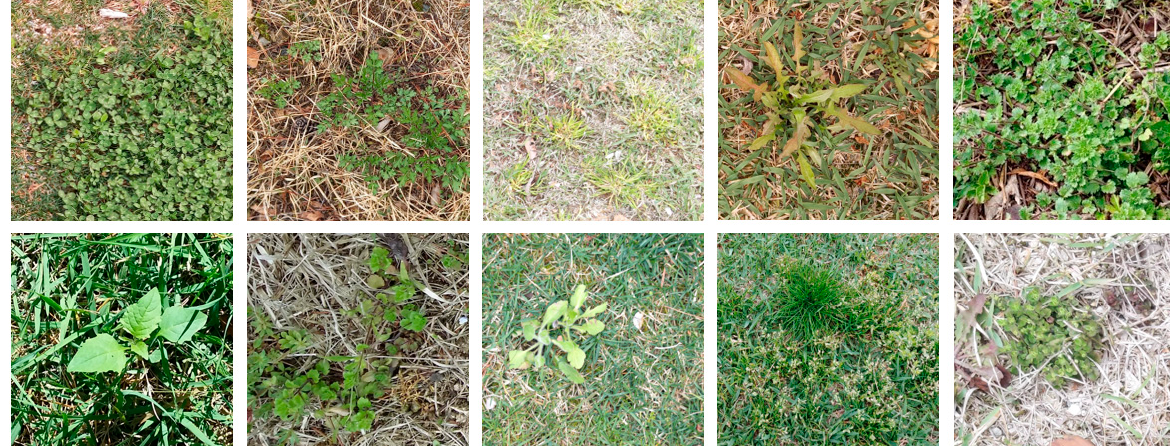
Figure 5. Examples of original images in the weed dataset. From left to right: The first row contains clover, common ragweed, crabgrass, dandelion and ground ivy; the second row contains lambsquarter, pigweed, plantain, tall fescue and unknown weed. (In the sample shown in this figure, each picture has only one category of weed, but each picture in the actual collected dataset may have the appearance of multiple types of weeds).